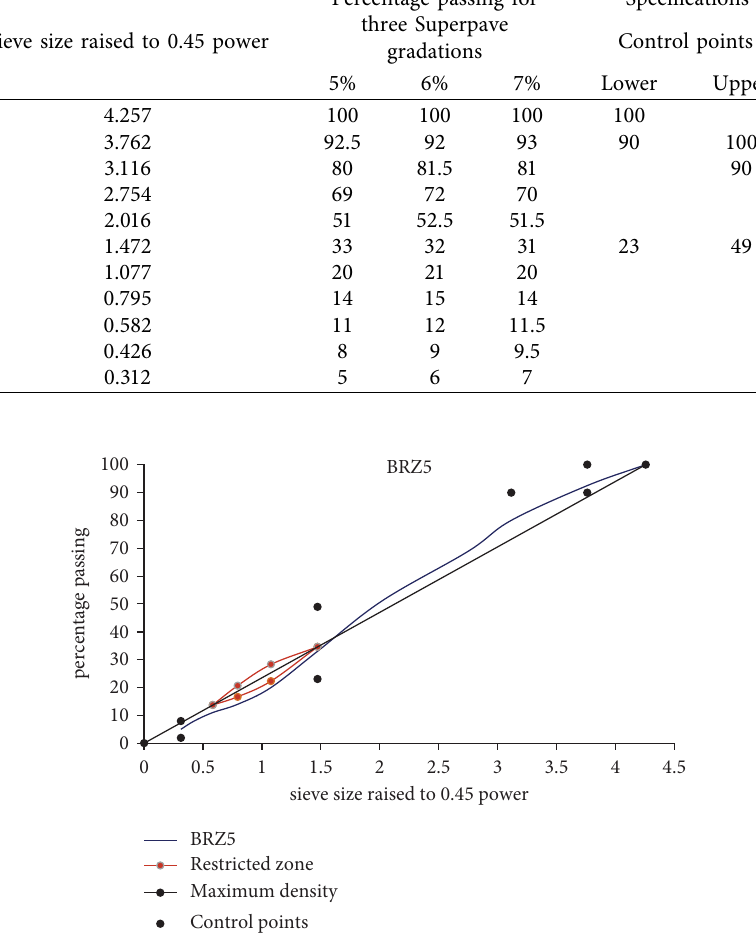
Table 7: Adopted Superpave aggregate gradation of asphalt mix for 19mm nominal size. Sieve size in (mm) Sieve size raised to 0.45 power